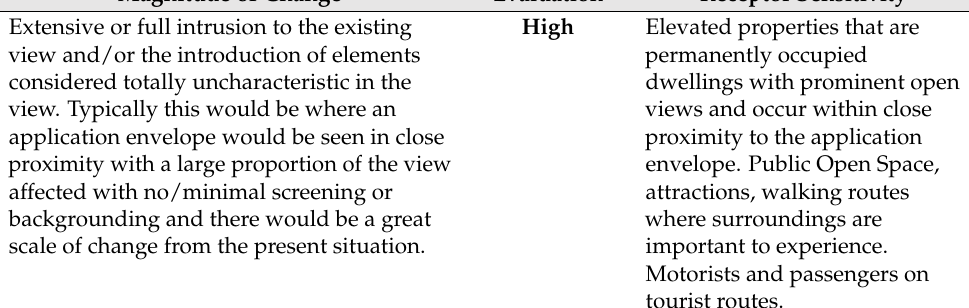
Table 1. Methodology for Determining Visual Impact Magnitude and Receptor Sensitivity. Magnitude of Change